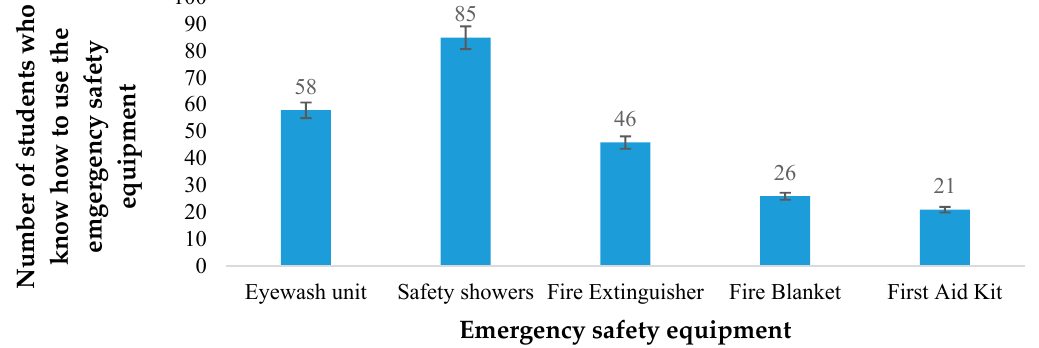
Figure 7. Student awareness of how to use the existing emergency safety equipment in laboratories.